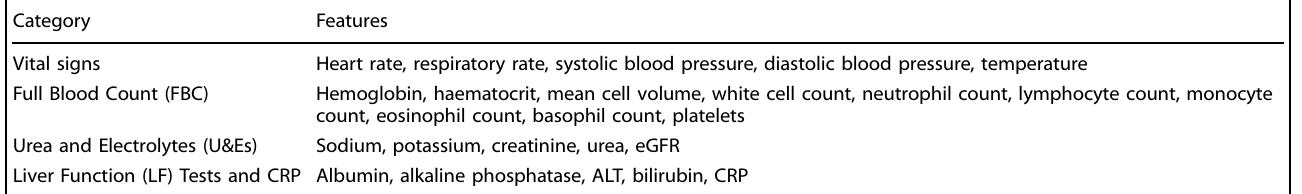
Table 3. Clinical predictors considered (ALT alanine aminotransferase, CRP C-reactive protein, eGFR estimated glomerular fi ltration rate).